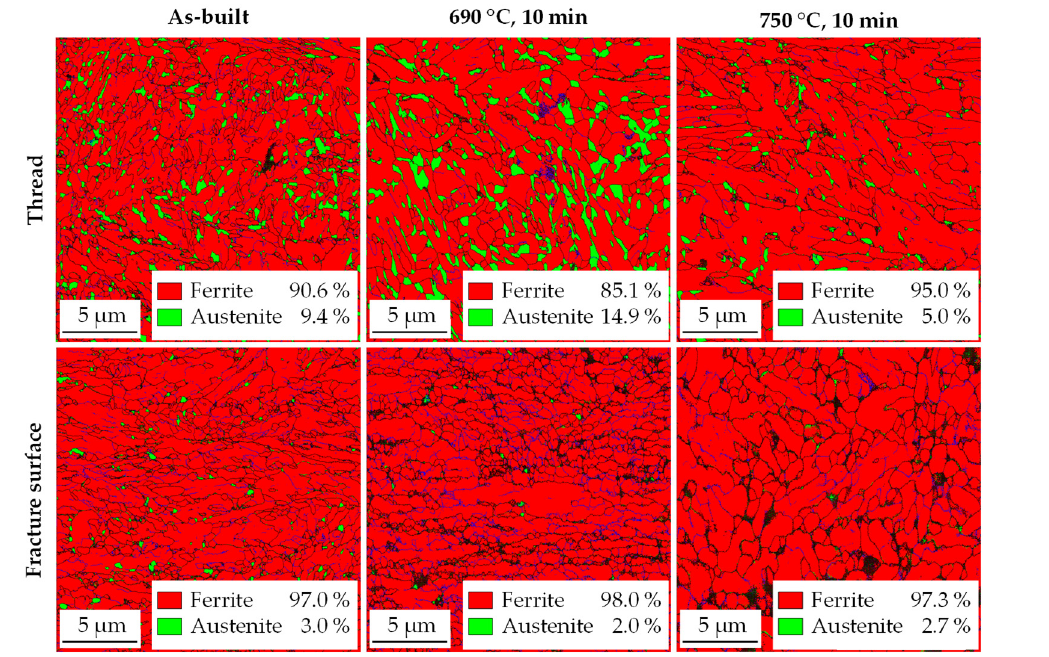
Figure 7. EBSD phase images of the threaded area and near the fracture surface as-built and after intercritical annealing at 690 °C and 750 °C for 10 min. The black areas could not be assigned.